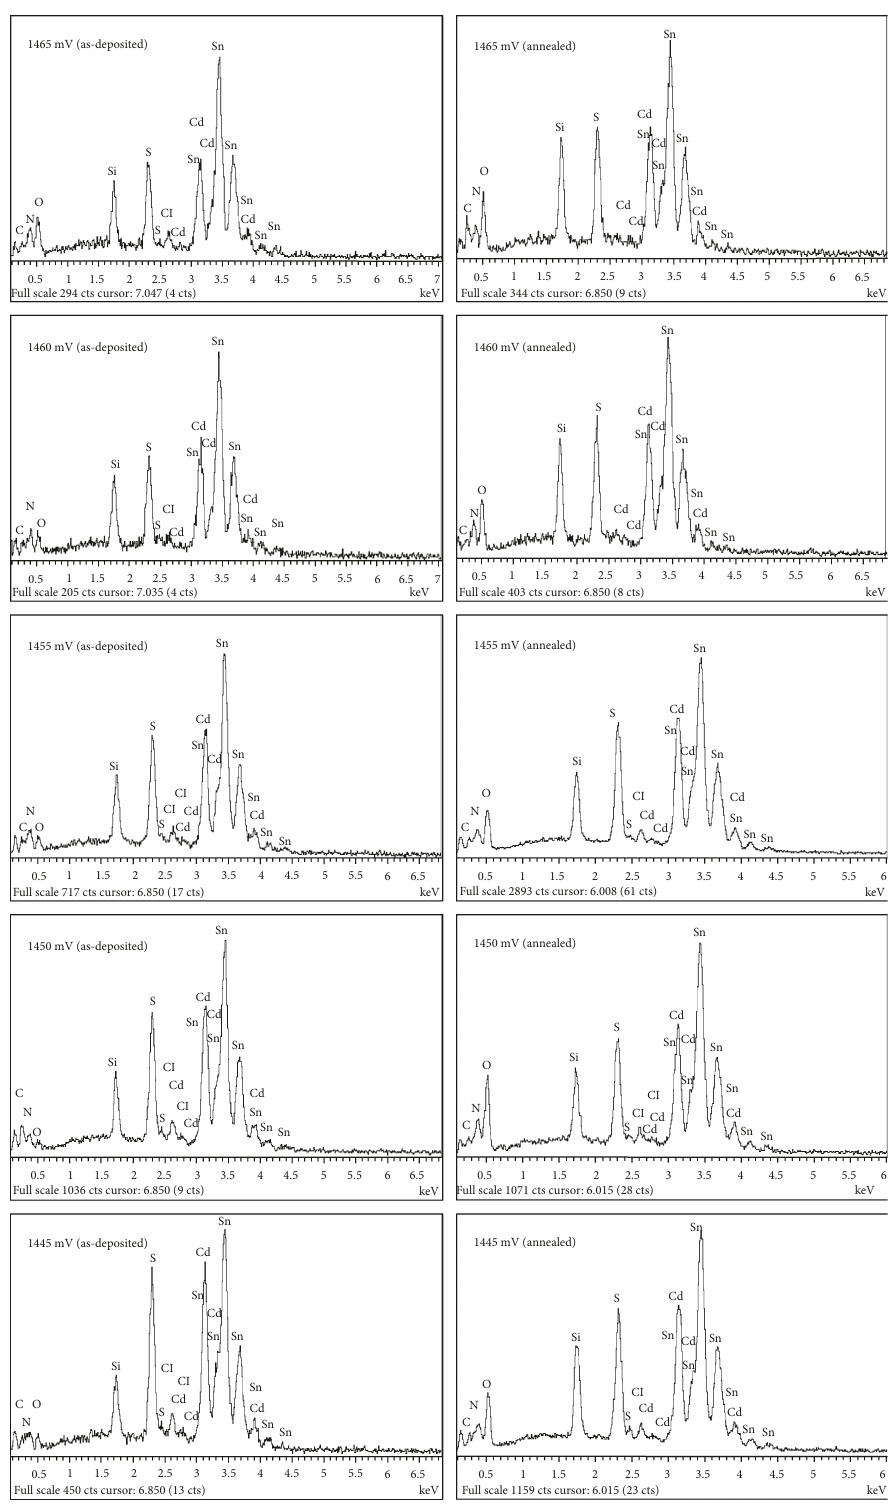
Figure 6: EDX spectra of as-deposited and annealed CdS samples grown at di ff erent cathodic voltages for 45 minutes. Annealing was preceded by CdCl 2 400 ° C for 20 minutes in air. The “ cementing ” e ff ect on the surface grains after annealing has not been observed in sam- ples annealed without this treatment [37]. This cementing